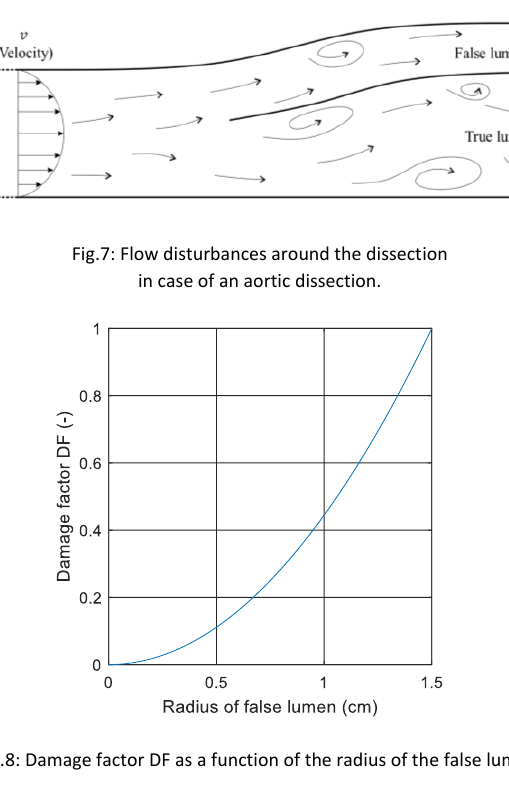
Fig.8: Damage factor DF as a function of the radius of the false